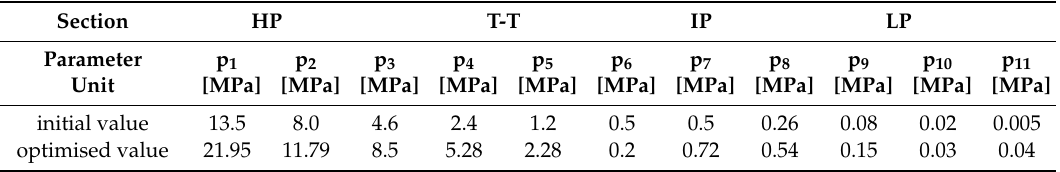
Table 9. The optimised pressure values collected from the case with the highest e ffi ciency gained.